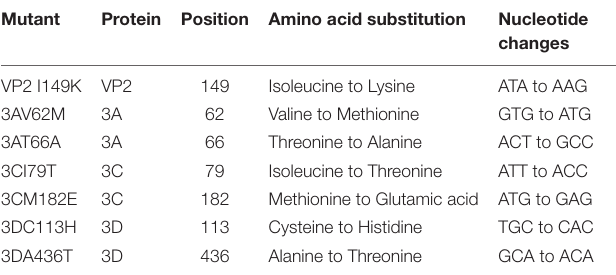
TABLE 1 | Amino acid substitutions introduced in the EV-A71 S41 infectious clone. Mutant Protein Position Amino acid